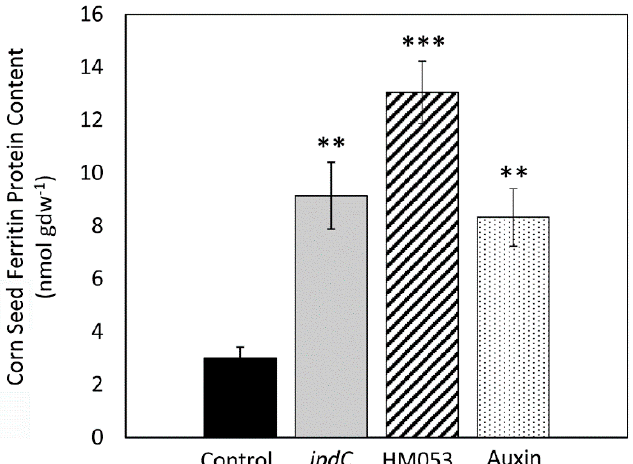
Figure 6. Seed iron-ferritin content as a function of treatment type. All treatment types showed significantly greater concentration of ferritin protein in maize seed relative to control with greatest elevation observed in the A. brasilense HM053-inoculated maize kernels. Data reflects N = 4 biological replicates for each treatment with error bars indicating ±SE. Paired comparisons were made using the Student t-test between single treatments and non-inoculated control plants. Asterisks indicate significant differences (** p < 0.01, *** p < 0.001) in these comparisons.